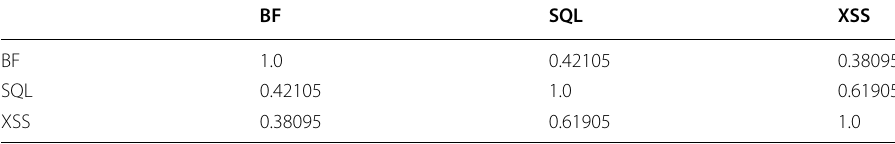
Table 9 Jaccard similarities by dataset for FST Agreement Lists where 4/7 FSTs Agree ( fst A